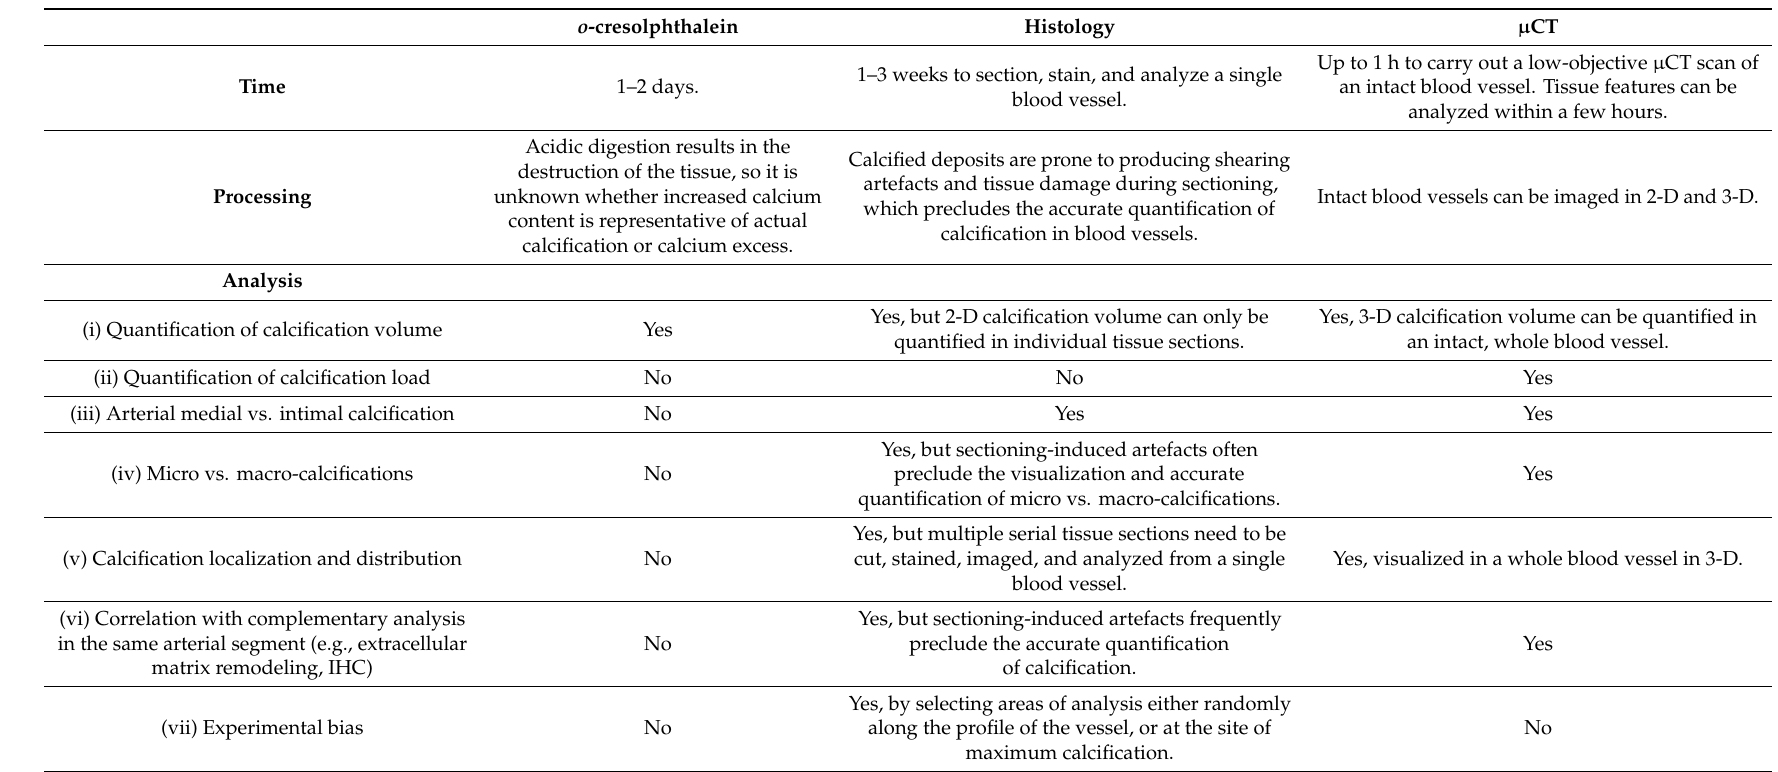
Table 4. Comparison of biochemical, histological, and µ CT